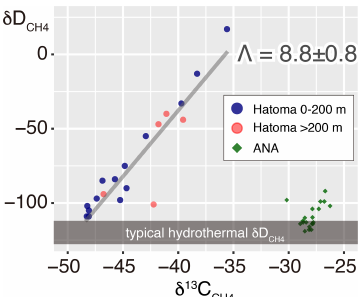
Figure 3. 13 C–D diagram for CH 4 . Symbols of Hatoma Knoll sam- ples are classified by color according to sampling altitudes below 200m (blue) and above 200m (pink). The grey diagonal line repre- sents a linear fitting for the Hatoma Knoll dataset.